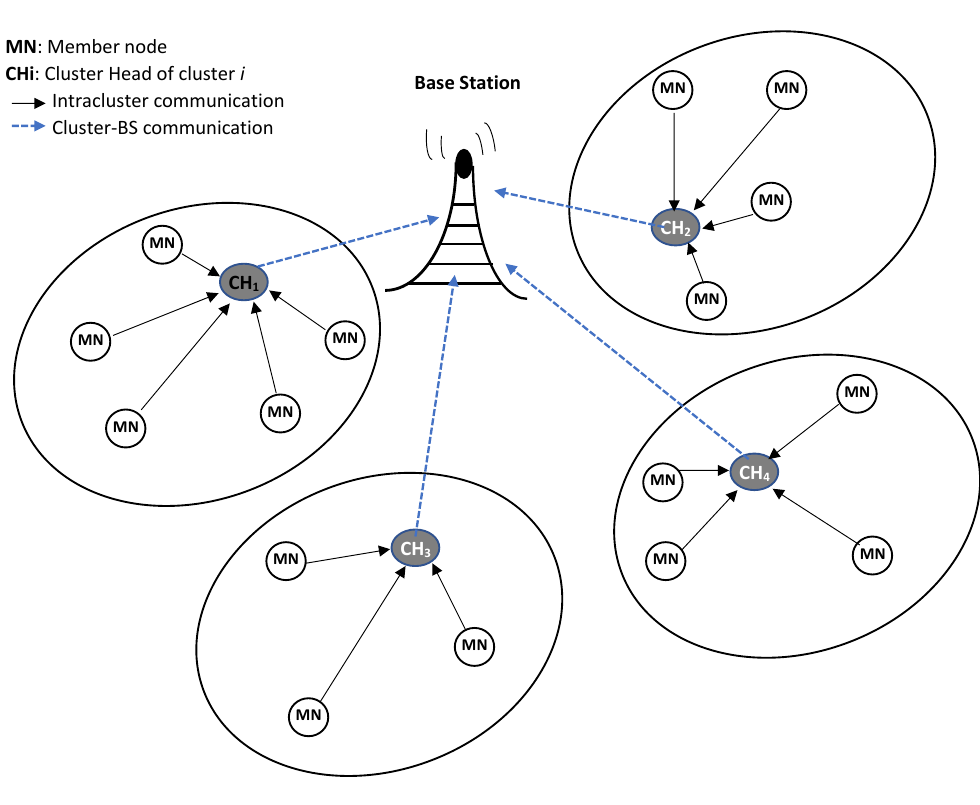
Figure 3. NB-IoT cell cluster